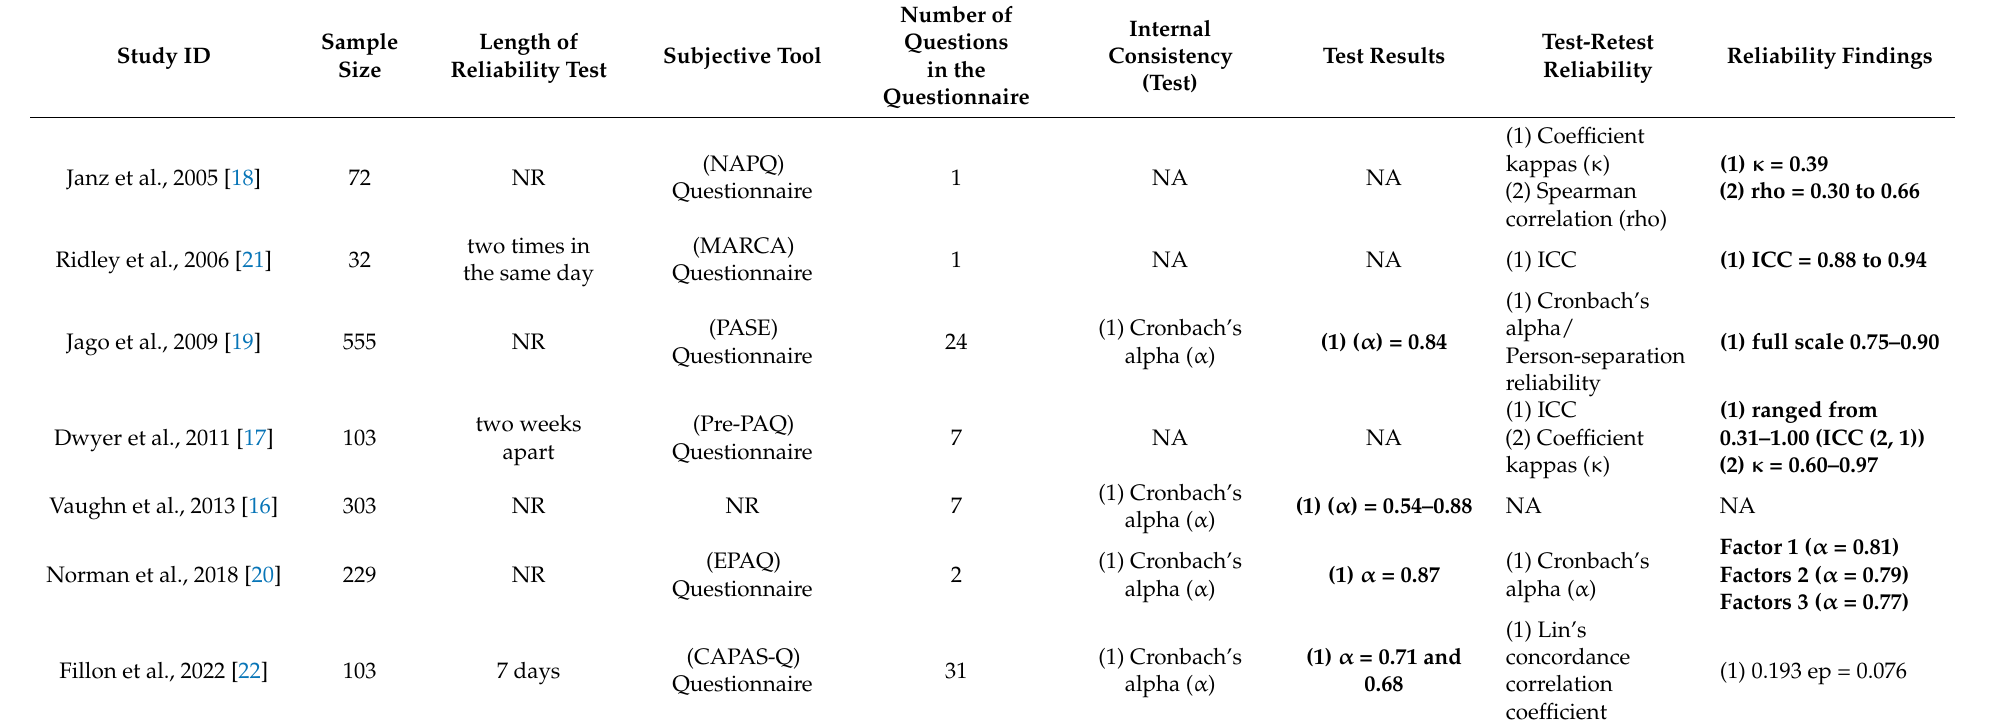
Table 2. Descriptive characteristics of the reliability